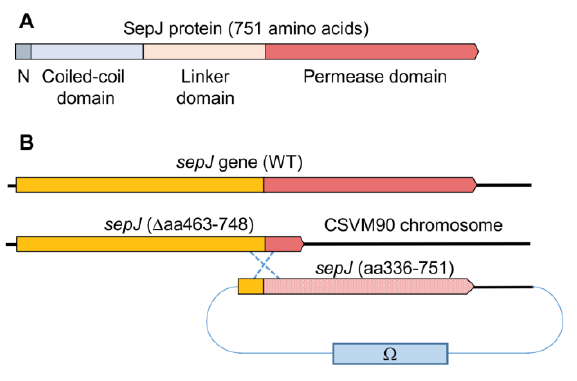
FIGURE 1: The SepJ protein and the sepJ gene from Anabaena . (A) Schematic showing the conserved domains of SepJ. (B) Sche- matic of the genetic strategy used to re-construct the sepJ gene using CSVM90 as parental